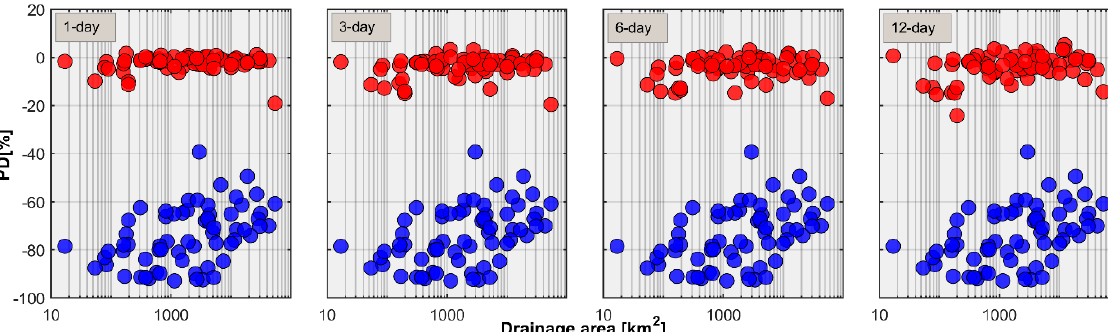
Figure A4. Relationship between peak difference, PD and drainage area across lead times. Blue dots correspond to the climatology forecasts and red dots correspond to the anomaly persistence-based forecasts.